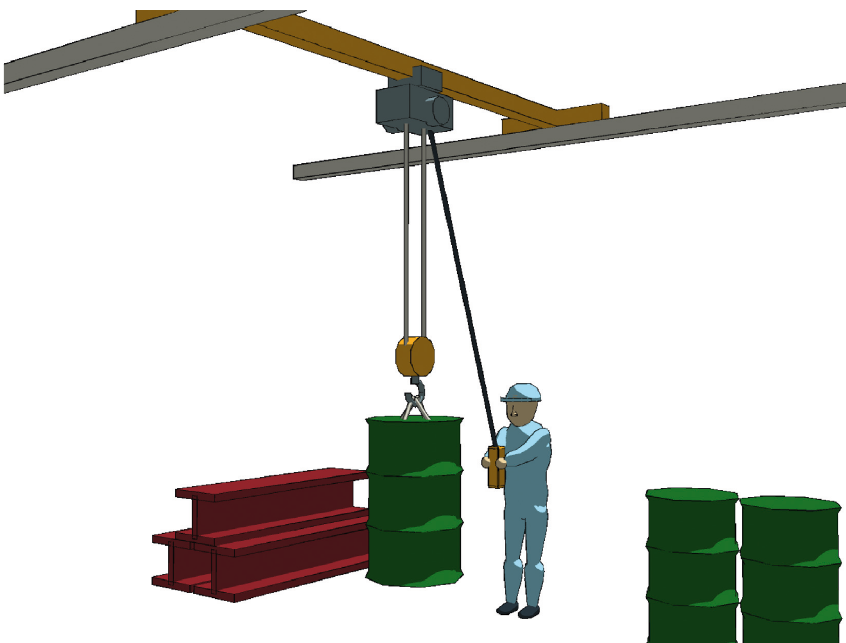
Figure 1: Illustration of electric overhead traveling crane with pendant-type operating